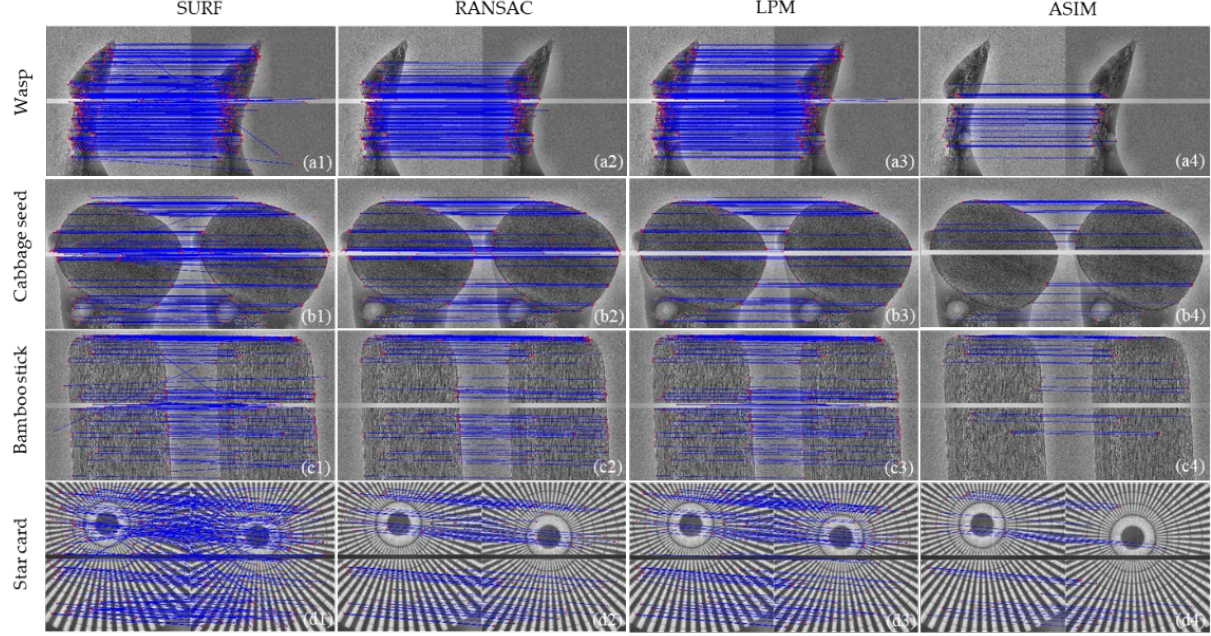
Figure 3. 2D transmission imaging results. Rows 1 through 4 show the matching results for wasp, cabbage seed, bamboo